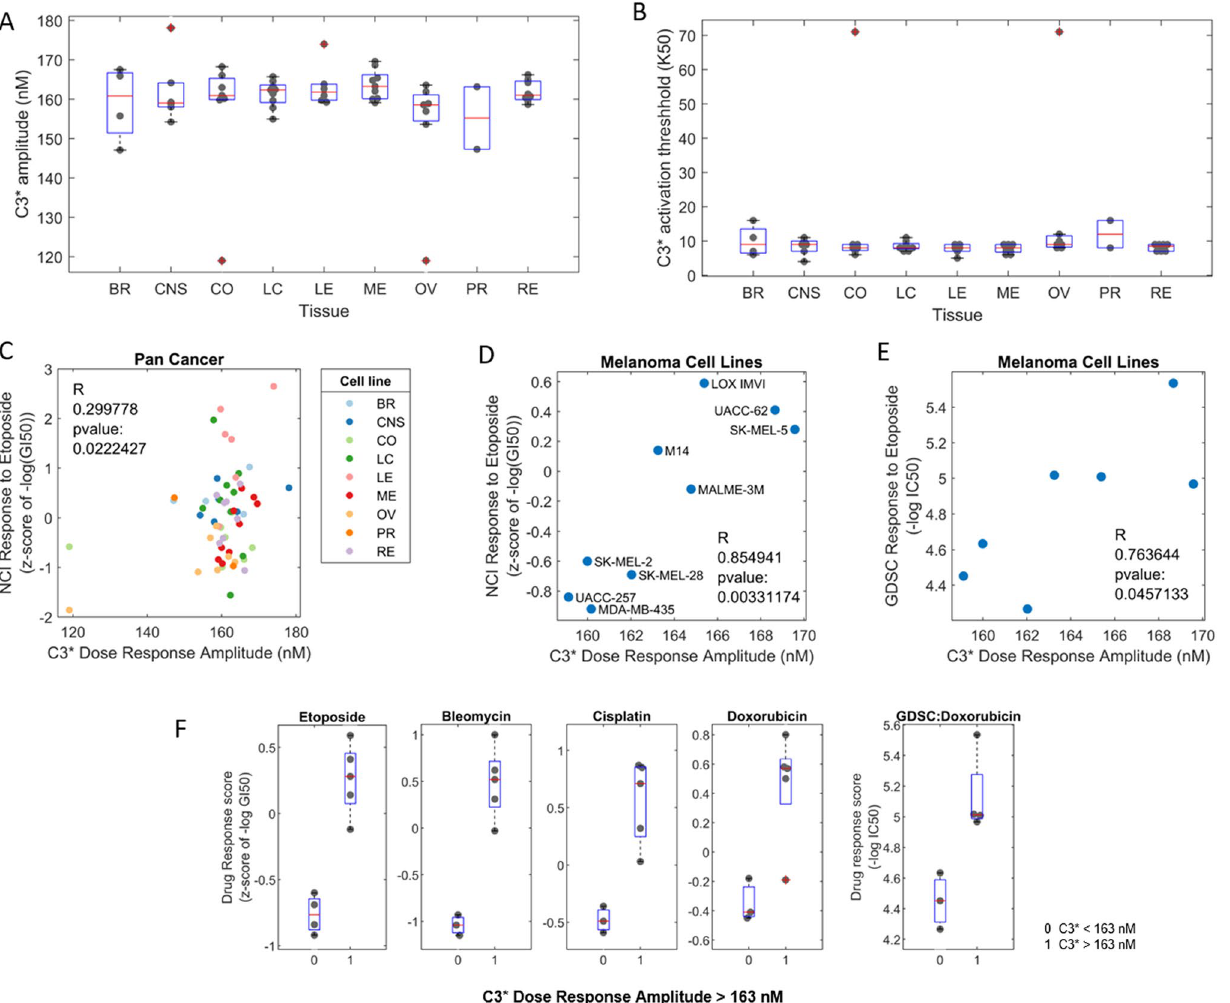
Figure 7. Cell Line Specific Simulations Correlate with Drug Response. ( A , B ) Distributions of the cell-line specific simulated caspase 3 activation amplitudes ( A ) and caspase 3 activation thresholds ( B ) for the issues indicated on the x-axis. Boxplots indicate the upper and lower quartile (blue box) and median (red line). Dots represent the simulated values for each cell line. BR breast, CNS central nervous system, CO colorectal, LC lung cancer, LE leukaemia; ME melanoma, OV ovarian cancer, PR prostate, RE renal cancer. ( C ) Pan cancer cell line specific simulations were carried out and C3 amplitude was correlated with cell line response to Etoposide (C = 0.3, p-value = 0.022). ( D ) Melanoma cell line specific simulations (n = 9) indicated a positive correlation with response to etoposide measured by the NCI-60 screen (C = 0.855, p-value = 0.003). ( E ) Melanoma cell line specific simulations (n = 7) are positively correlated with etoposide response measured in the GDSC screen (C = 0.76, p-value = 0.046). ( F ) Classification of the melanoma cells into sensitive and insensitive cell lines. Shown are the distributions of the indicated drug responses (y-axis) for cells with a low simulated caspase 3 activation amplitude (< 163 nM) on the left (0) and cells with a high amplitude (> 163 nM) on the right (1). Boxplots indicate the upper and lower quartile (blue box) and median (red line). Dots represent the values for each cell